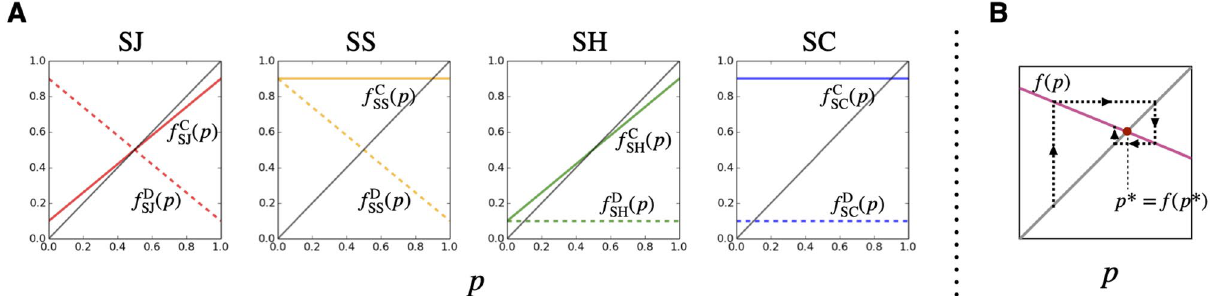
0.1 . From the left to e 2 = =